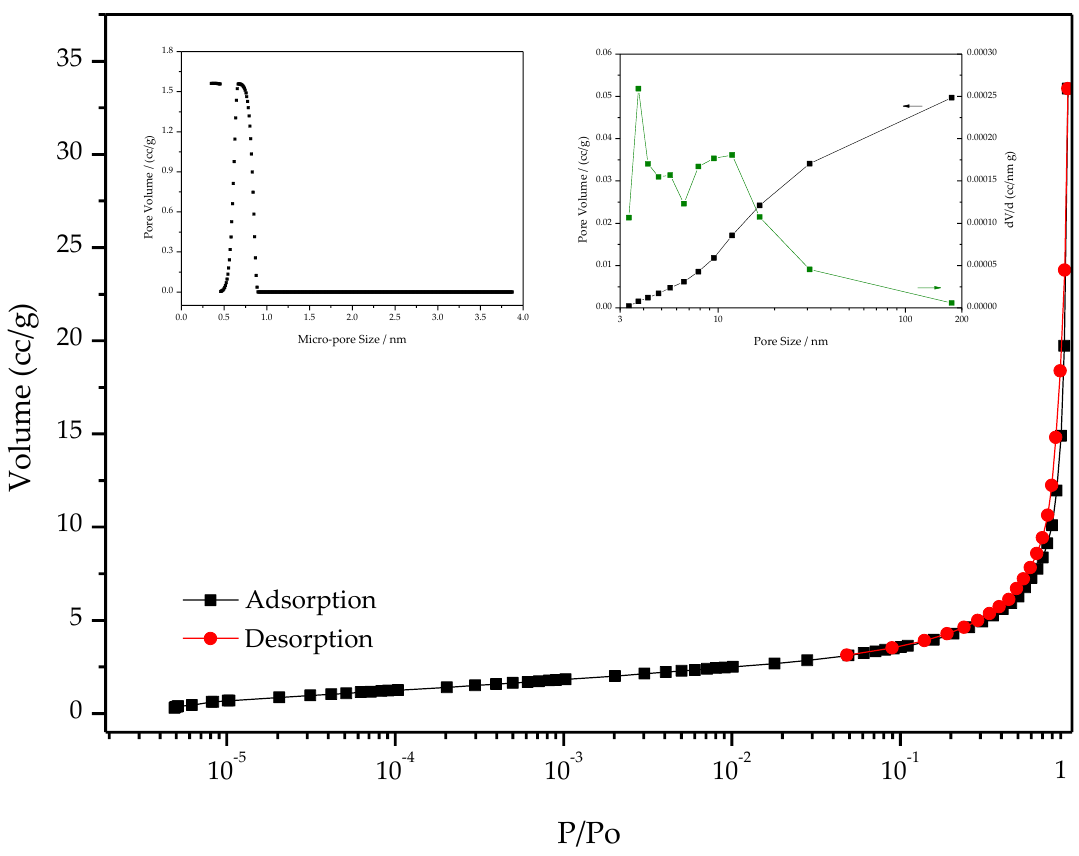
Figure 9. N 2 adsorption-desorption isotherms of No. 20. The inset figures show the pore size distributions of the micropores and mesopores.